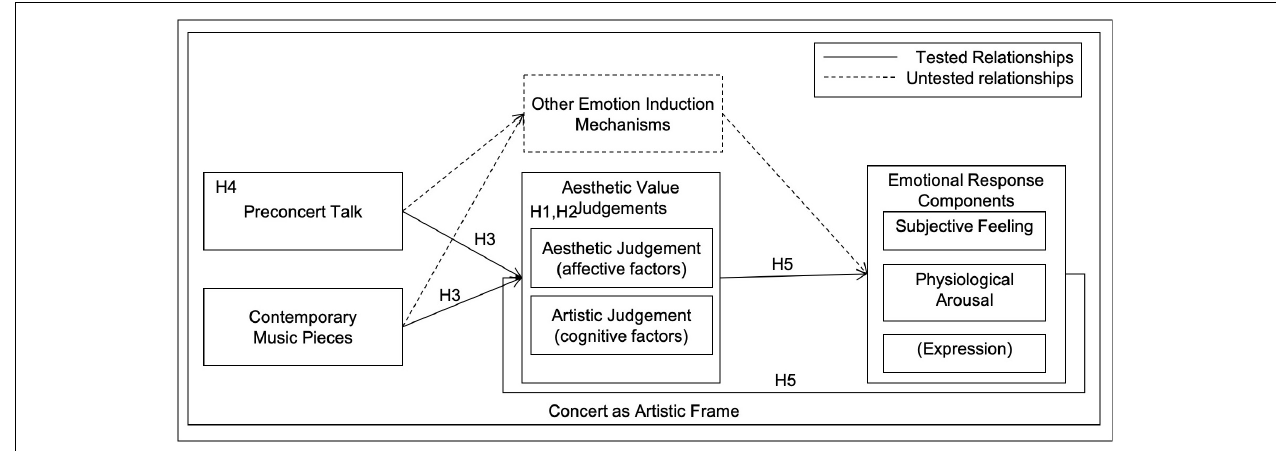
FIGURE 1 | Theoretical model tested in this study with individual